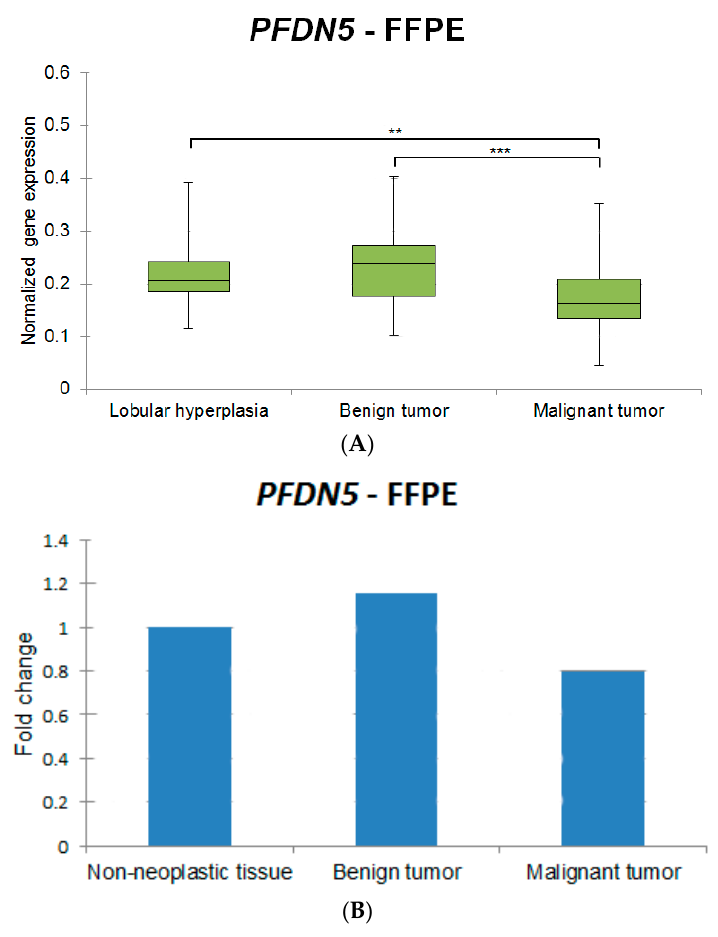
Figure 2. ( A ) Exemplary box plot indicating the normalized gene expression of PFDN5 in formalin-fixed, paraffin-embedded samples in the different histologic groups. Statistically significant differences are indicated by an asterisk (*). Results are classified as very significant (** p < 0.01) and extremely significant (*** p < 0.001). The box includes cases from the 25th to the 75th percentile. The horizontal line within the box represents the median and the upper and lower bars are the largest and lowest observed values. Significant differences are revealed between the groups lobular hyperplasias vs. malignant tumors and benign tumors vs. malignant tumors. A lower level of expression can be clearly identified when comparing the expression of PFDN5 in fresh frozen samples (Figure 1); ( B ). Normalized expression fold changes (mean) indicating the percentage change of PFDN5 in formalin-fixed, paraffin-embedded samples in the different histologic groups.